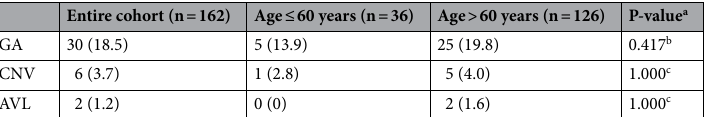
Table 4. Age-related variations in macular complications of cuticular drusen. Data are number (%) or mean ± standard deviation, unless otherwise indicated. AVL acquired vitelliform lesion, CNV choroidal neovascularization, GA geographic atrophy, PED pigment epithelial detachment. a Comparison between eyes in patients ≤ 60 years and those > 60 years of age. b Chi-square test. c Fisher’s exact